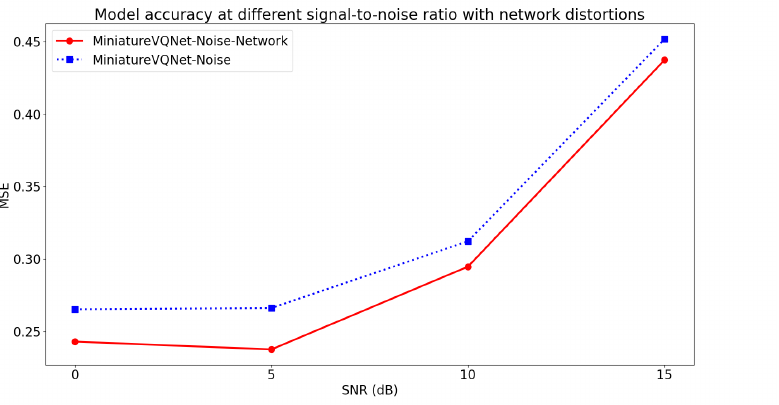
Figure 3. Model accuracy at different signal-to-noise ratios on noise–network-distorted speech